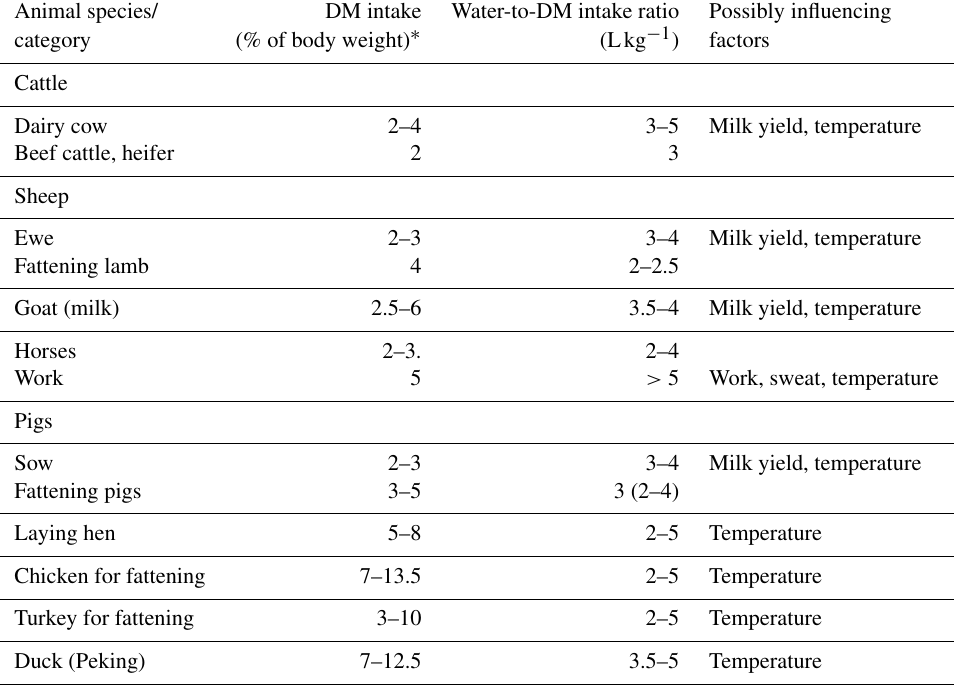
Table 5. Dry matter (DM) and water intake (in relation to DM intake) of various animal species and categories (Kamphues et al., 2014). Animal species/